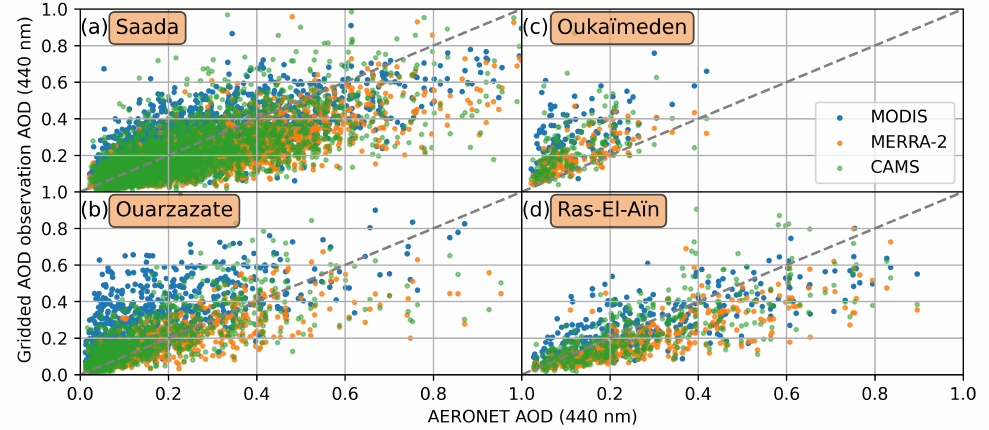
Figure 5. Comparisons of AOD 440 between AERONET and MODIS (blue dots), MERRA-2 (orange dots) or CAMS (green dots) for ( a ) Saada, ( b ) Ouarzazate, ( c ) Oukaïmeden and ( d ) Ras-El-Aïn. The 1:1 line is represented by the dashed